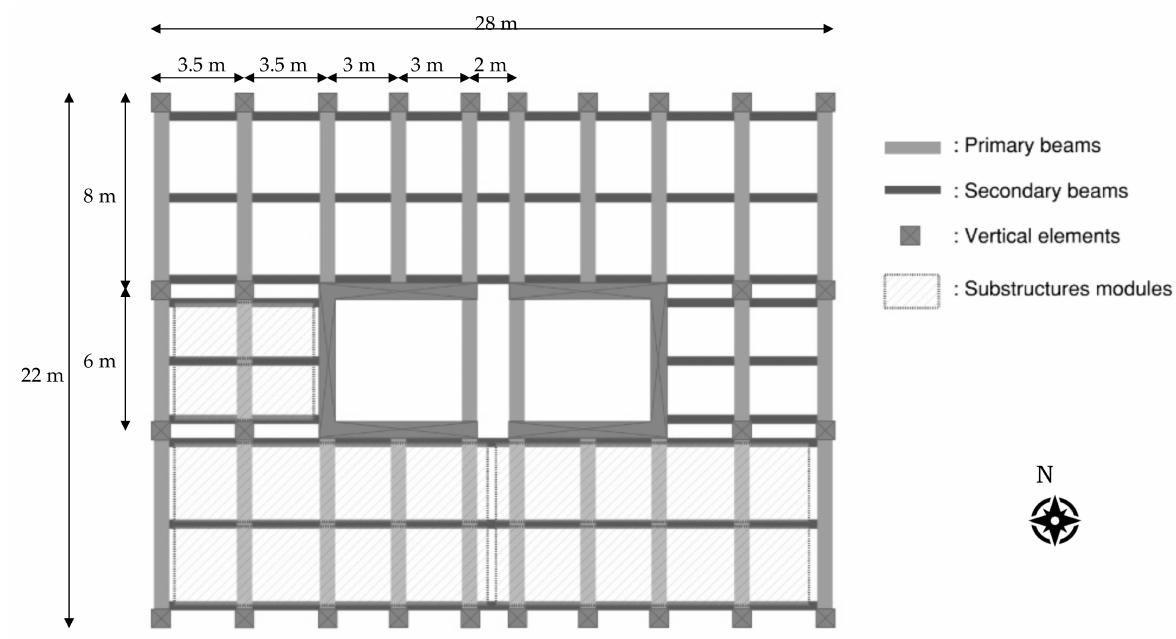
Figure 1. Hyperfloors’ arrangement of beams and